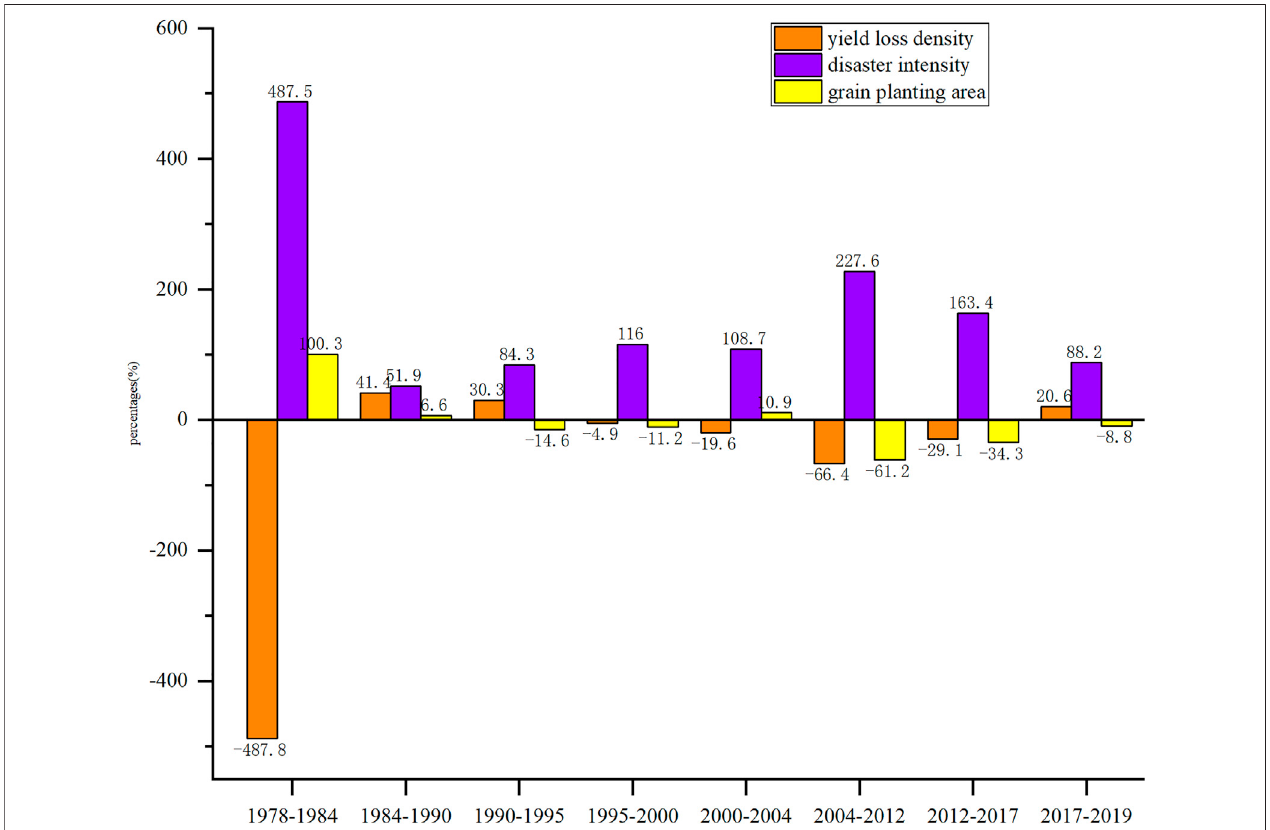
FIGURE 4 | Contributions of driving factors to changes in disaster-induced grain yield loss between 1978 and 2019.